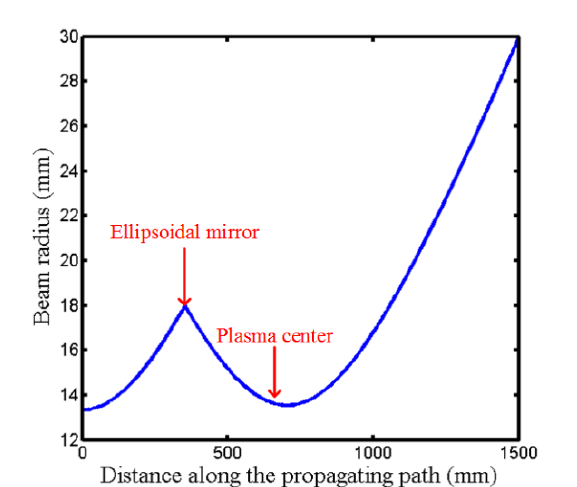
Fig. 4 . Beam radius along the propagation path (plasma center,